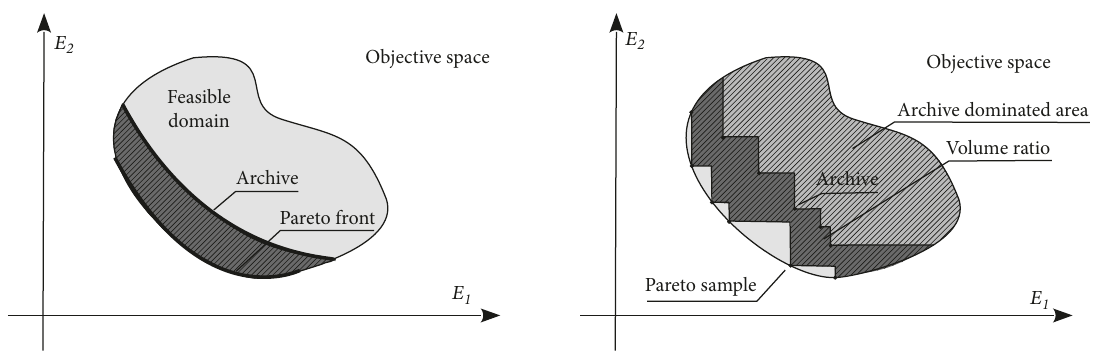
Figure 4: Hypothetical volume domination versus practical volume